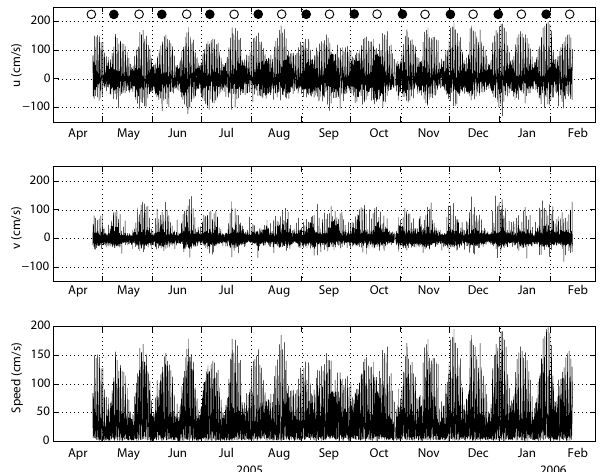
Fig. 10. The u-component (top), v-component (middle) and total speed (bottom) at 420m depth (40m off the bottom) at mooring L1 in the Luzon Strait. Positive (negative) u is towards the Pacific (South China Sea) side and represents the ebb (flood) tide. Positive (negative) v is towards the north (south) and represents the flood (ebb) tide. The lunar cycle is indicated across the top of the plot, with hollow circles indicating the time of the full moon and solid circles the new